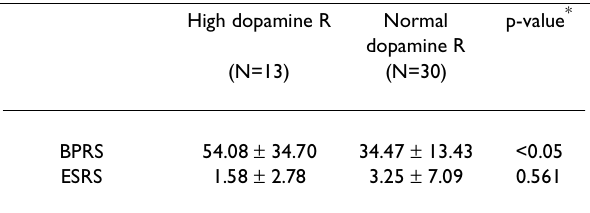
Table 5: Comparison of clinical profiles according to the level of dopamine receptor mRNA before medication (mean ± SD) High dopamine R